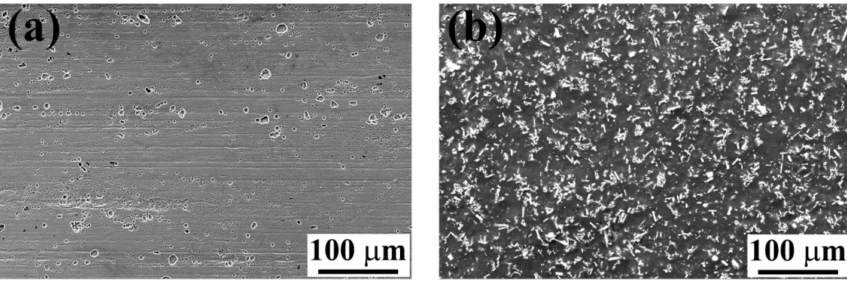
Figure 6. SEM images of the pre-treated aluminum surface ( a ) PAA and ( b ) PAA-P specimens. Reproduced with permission from [30].